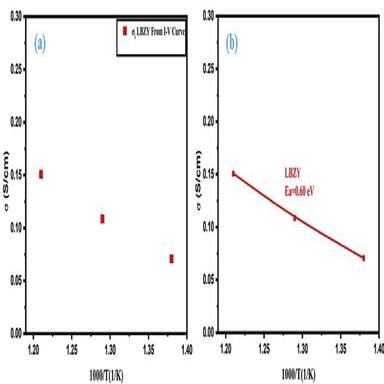
(a) Ionic conductivity of LBZY and (b) Activation energy of La-doped BZY electrolyte at different temperatures 450e550 C.